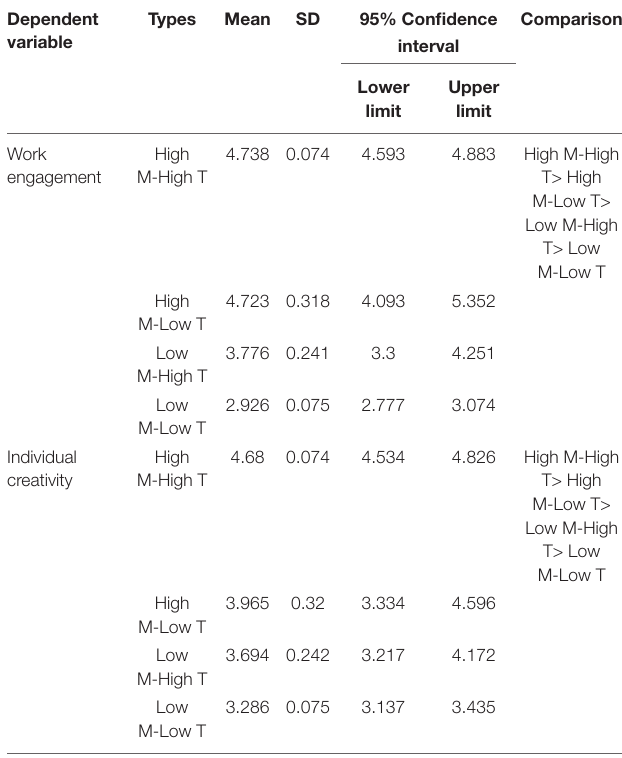
TABLE 3 | Interaction effect analysis of morality and talent ( N =